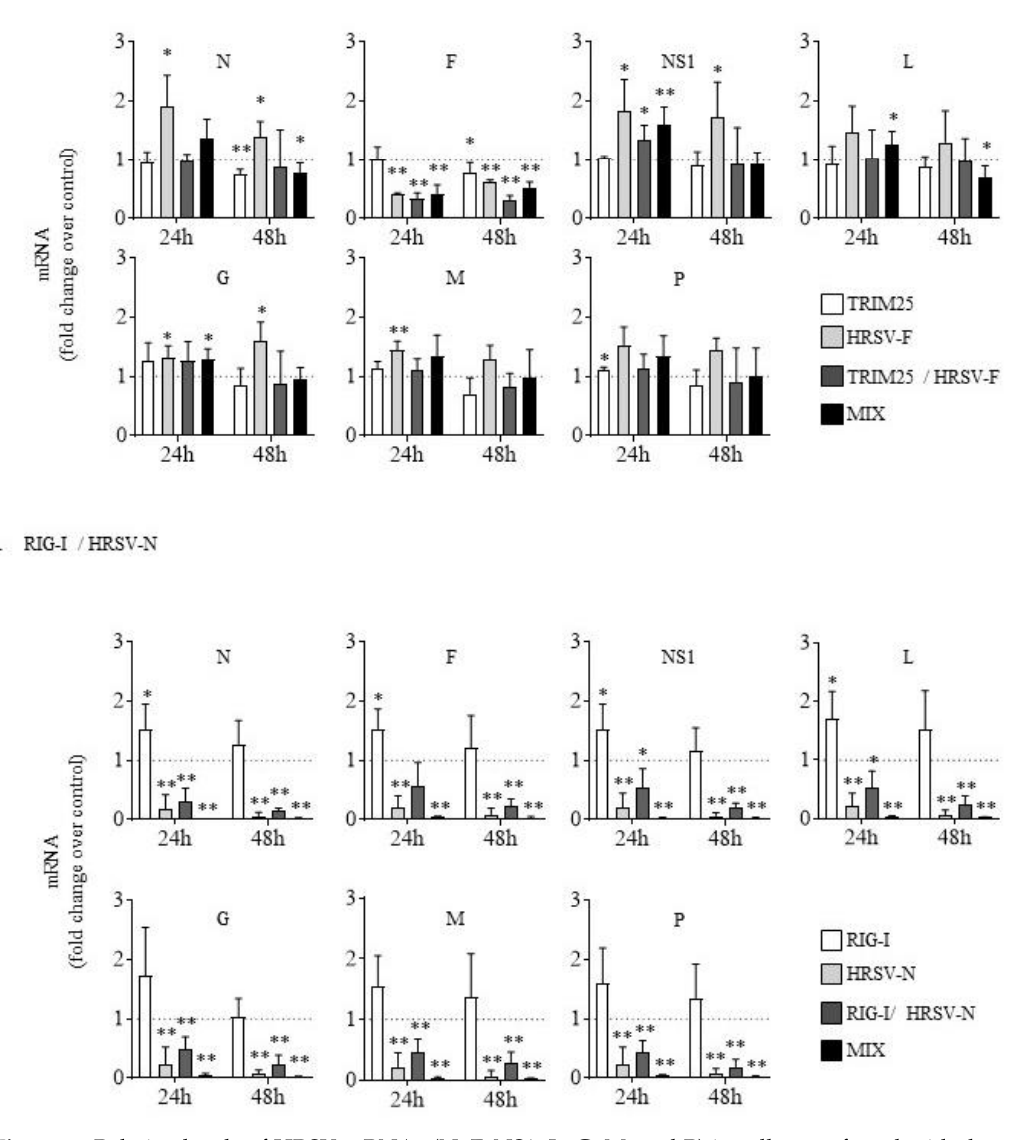
Figure 3. Relative levels of HRSV mRNAs (N, F, NS1, L, G, M, and P) in cells transfected with the di ff erent siRNAs. ( A ) Cells transfected with the siRNAs TRIM25, HRSV-F, TRIM25 / HRSV-F or a combination of TRIM25 plus HRSV-F (MIX). ( B ) Cells transfected with the siRNAs RIG-I, HRSV-N, RIG-I / HRSV-N or a combination of RIG-I plus HRSV-N (MIX). Cells were transfected with the siRNAs and infected 24 h later at an MOI of 3. Levels of HRSV mRNAs were quantified by quantitative real time-PCR at 24 and 48 hpi and represented as fold over viral mRNAs expressed in cells transfected with a control siRNA. Data represent the mean and standard deviation from three independent experiments. Comparisons between groups were done by the t -test: *, p < 0.05 and **, p < 0.01.